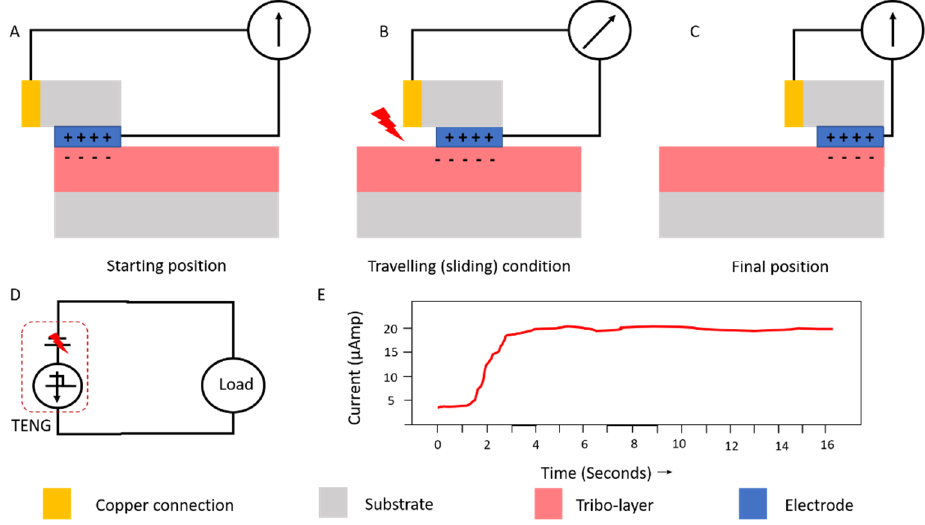
Figure 15. Triboelectric nano electricity generation (TENG) principle.